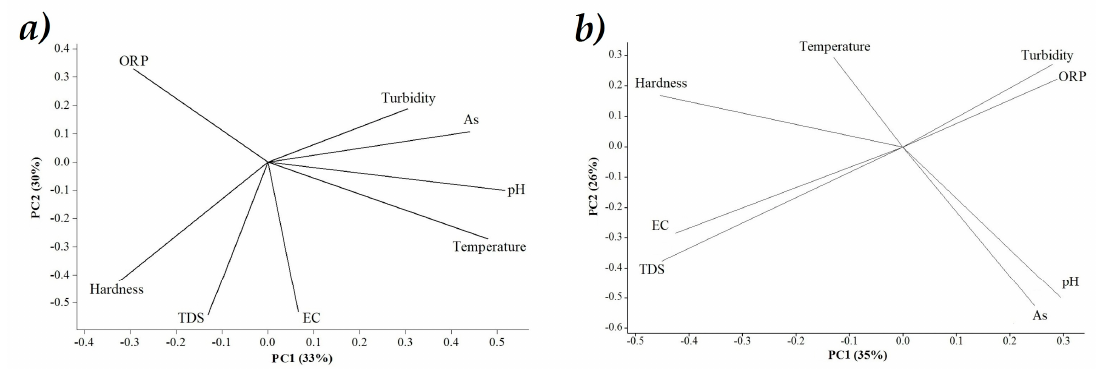
Figure 3. Plot S1 comparison PC1 vs. PC2 ( a) , Plot S2 comparison PC1 and PC2 ( b ).